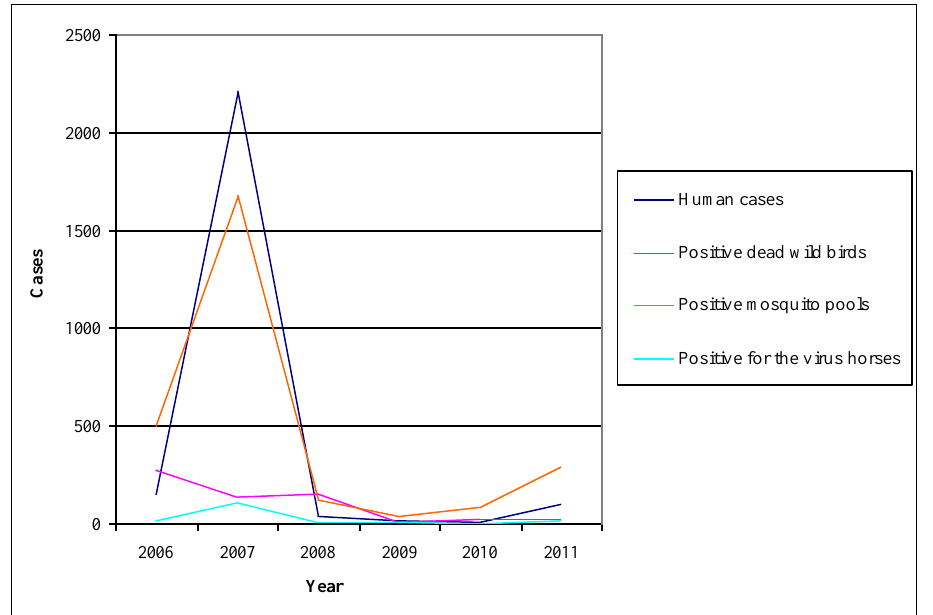
Figure 11. Surveillance system results fluctuation in Canada, 2006–2011 (data available